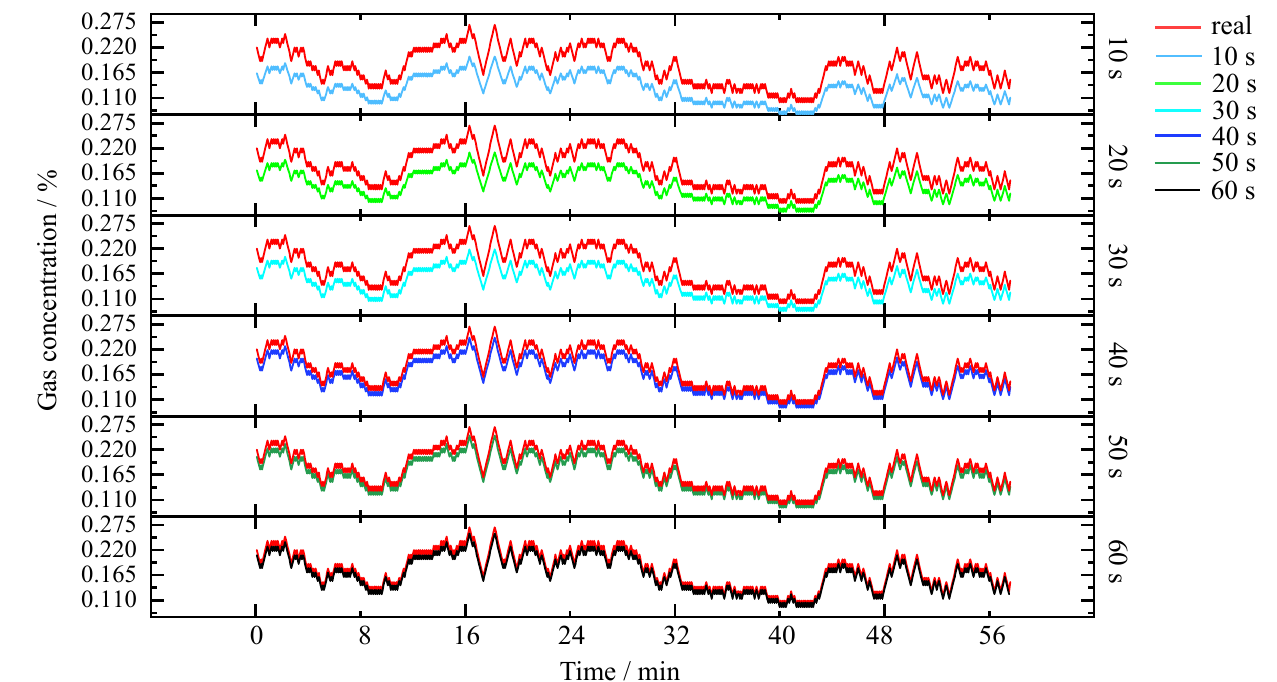
Figure 11. Gas concentration prediction of the model with an update period of 60 s.